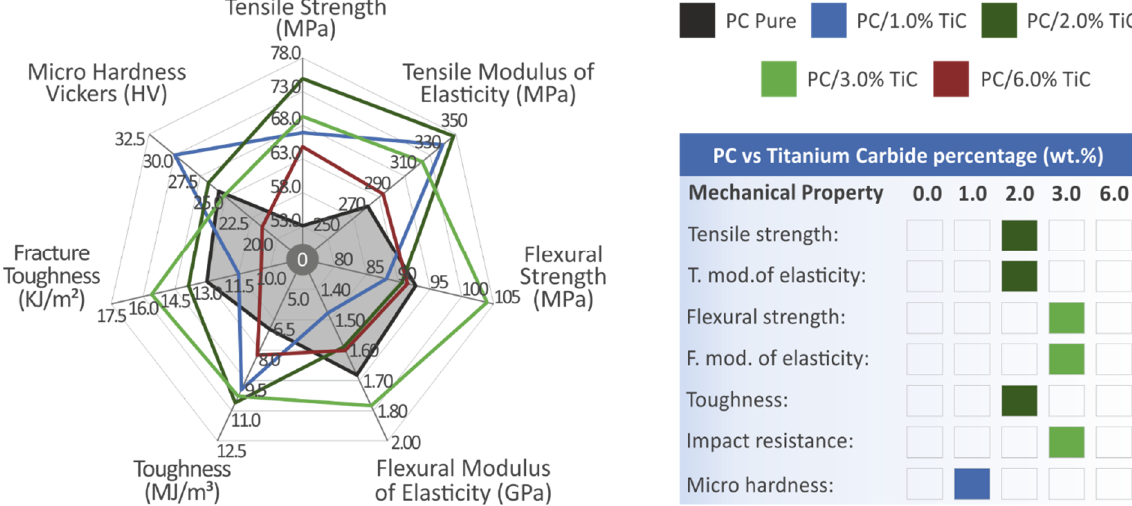
Figure 17. Summary of the mechanical tests’ results. The shaded area in the spider graph depicts the pure PC material’s mechanical properties. On the right side, the filler loading that exhibited the highest performance on each test is shown.